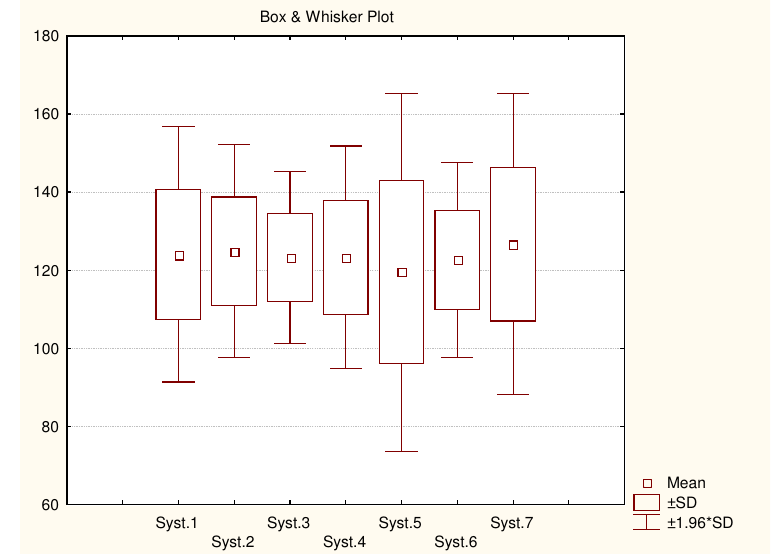
Fig 1. Variation in arterial systolic blood